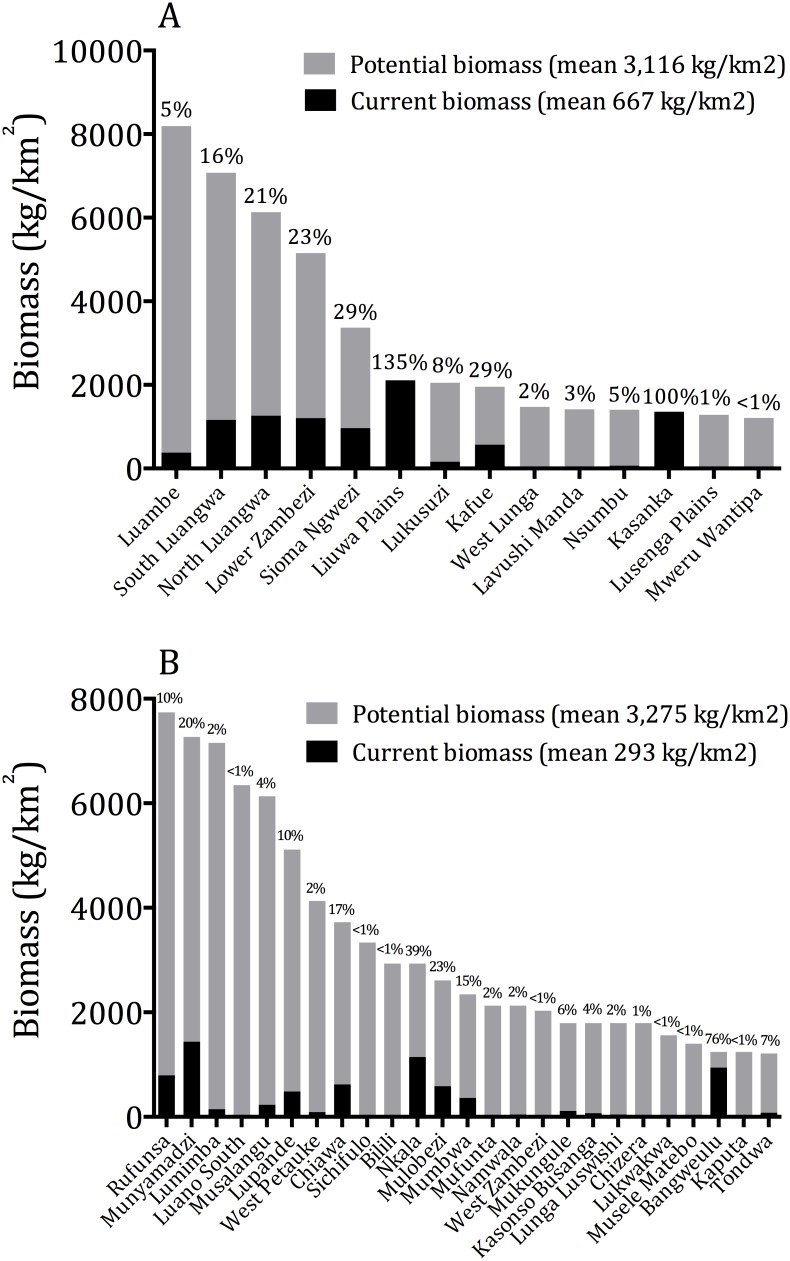
Observed large mammal biomass versus potential carrying capacity in Zambian (a) national parks and (b) GMAs.